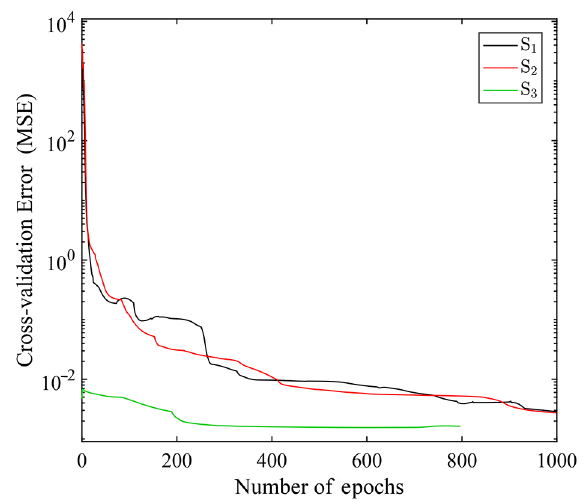
Figure 10. Cross-validation curves